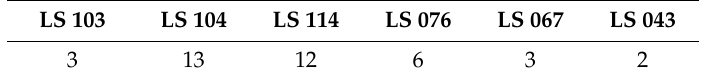
Table 3. β -ODAP dilution integrity (accuracy, %) in di ff erent grass pea samples.